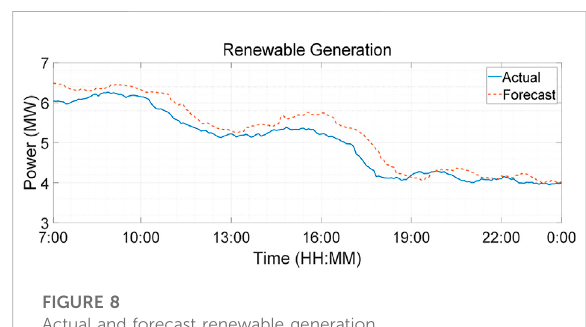
FIGURE 8 Actual and forecast renewable